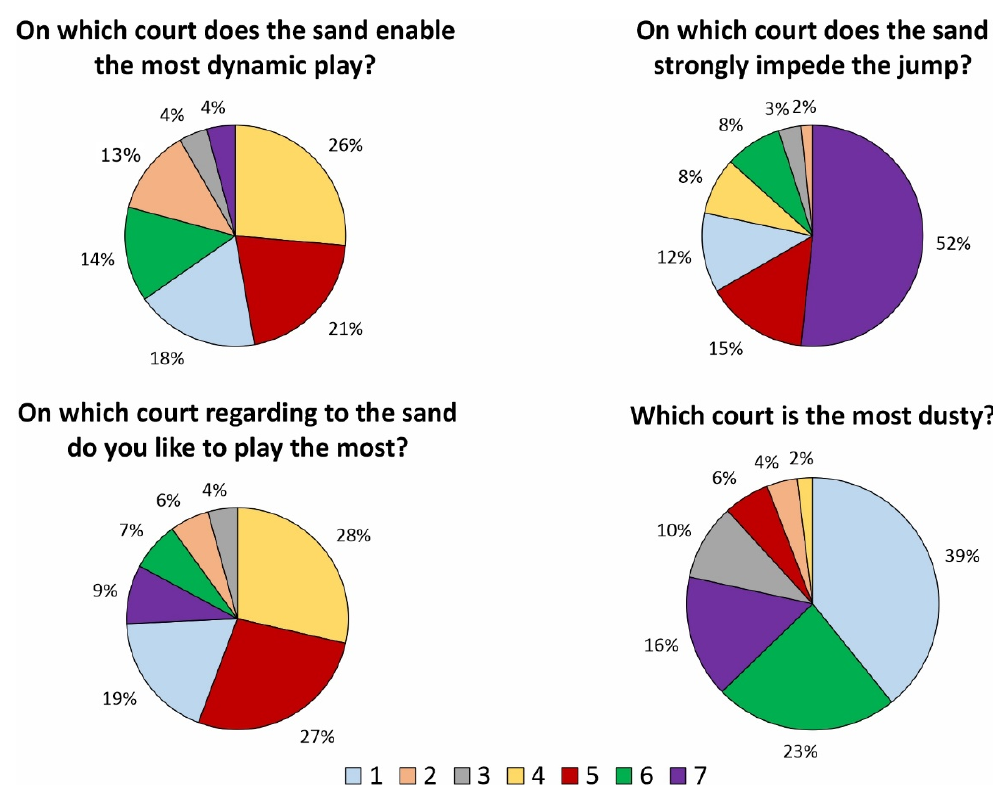
Figure 7. Results of the survey conducted among beach volleyball players playing in Wroc ł aw.